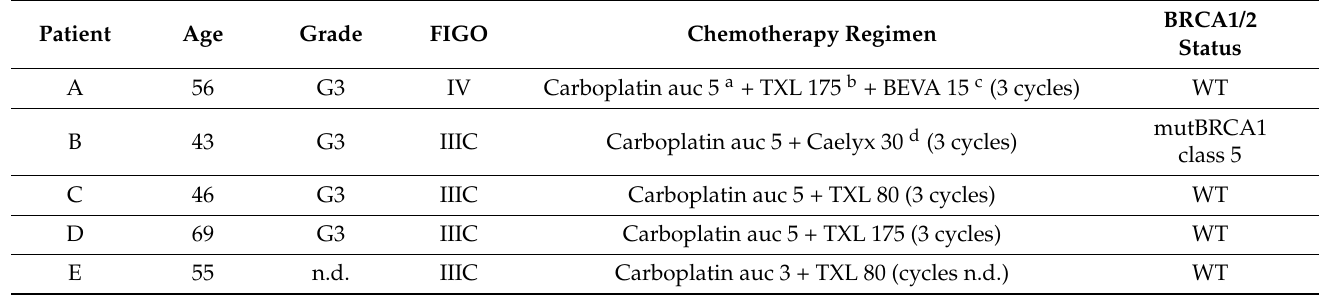
Grade 3: (high grade) poorly differentiated ovarian epithelial cancer cells. FIGO classification: IIIC: Tumor involves one or both ovaries with macroscopic (>2 cm) cytologically or histologically confirmed metastasis to the peritoneum outside the pelvis and/or to the retroperitoneal lymph nodes. IV: Distant metastasis excluding peritoneal metastasis. Includes hepatic parenchymal metastasis. a AUC: area under the curve, b TXL: paclitaxel 175 mg/m 2 , c BEVA: bevacizumab, d Caelyx: liposomal doxorubicin 30 mg/m 2 , WT: wild type, mutBRCA1: